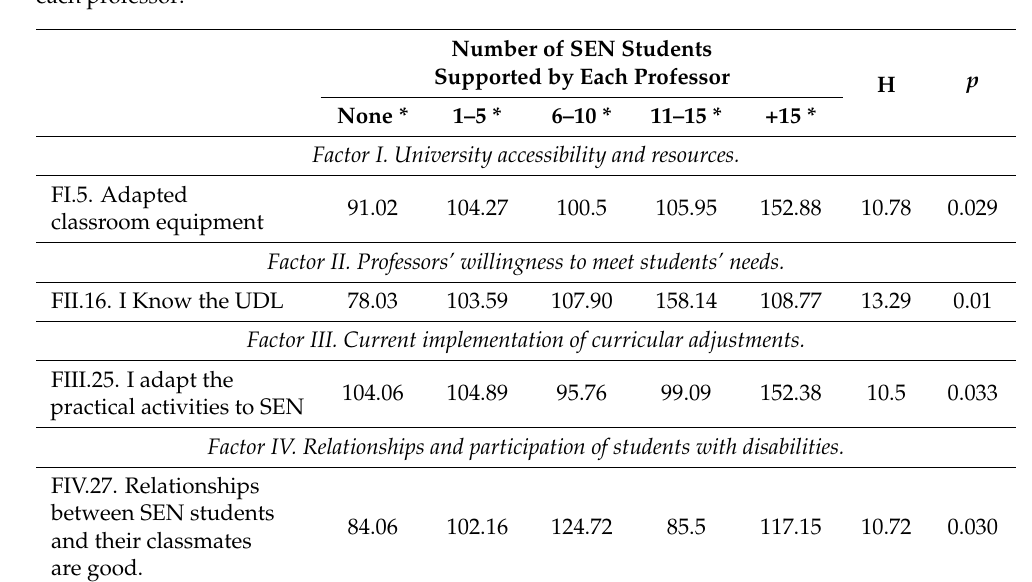
Table 15. Kruskal–Wallis analysis analysis according to number of SEN students supported